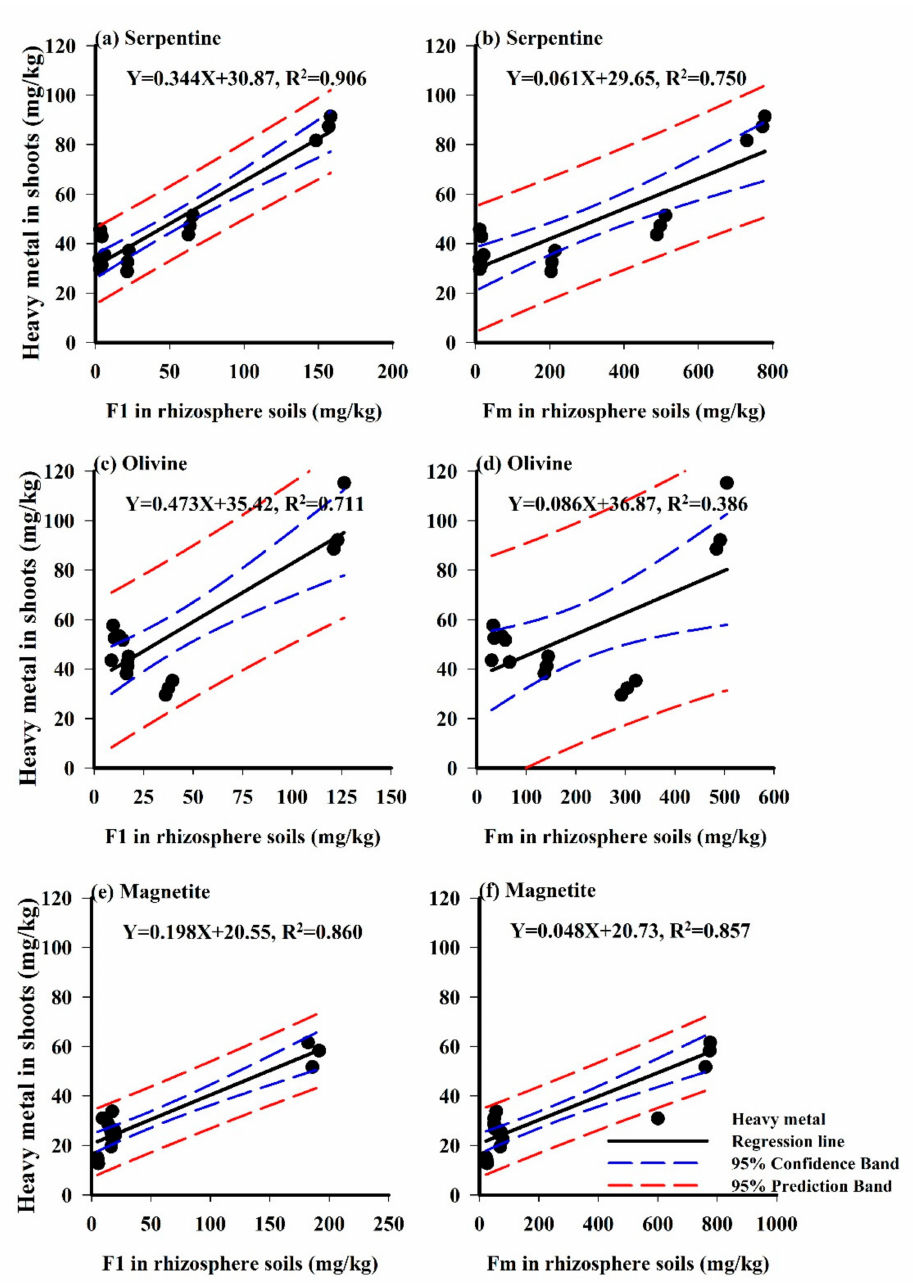
Figure 4. Diagrams of linear regression analysis between heavy metals in shoots and metal fractions in three-type tailing soils. The letters ( a – f ) indicate the order of the graph for illustration in the